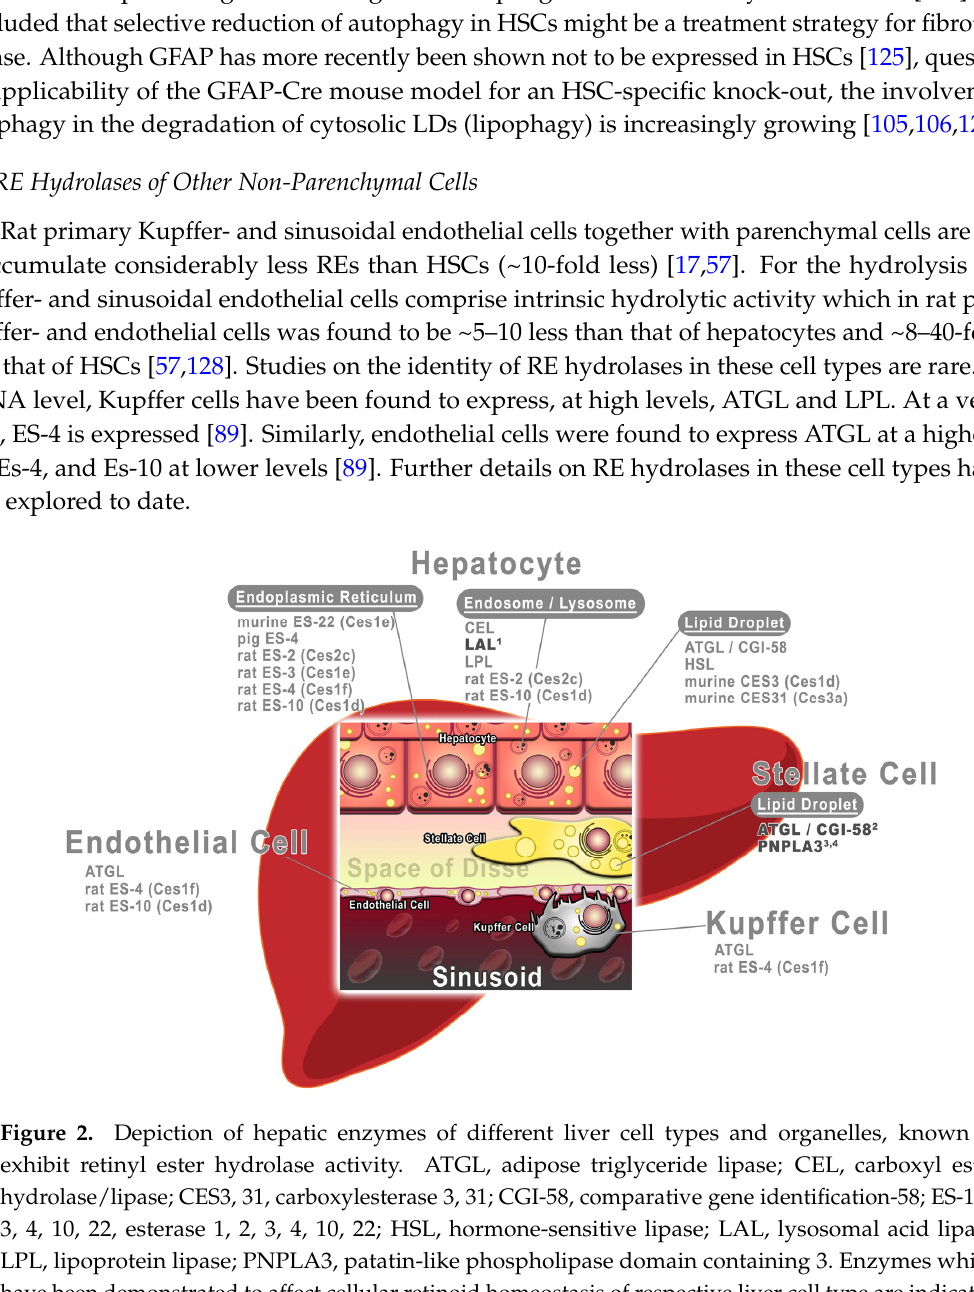
Genet 2016 ahead of